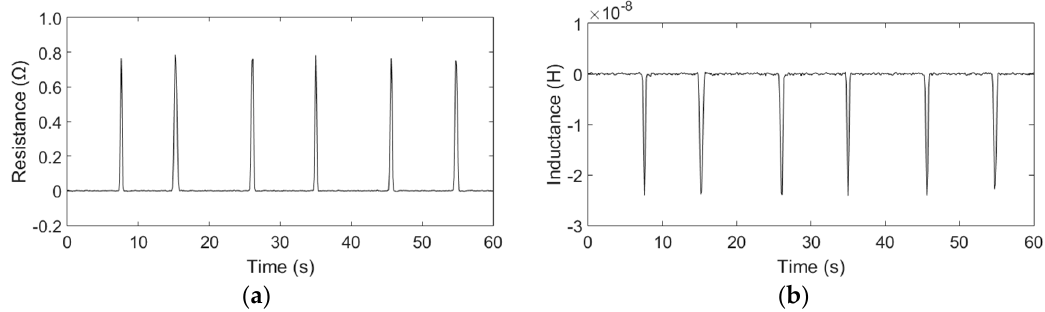
Figure 5. Detection results of the copper particles with sizes ranging from 150 μ m to 160 μ m: ( a ) Resistance detection results; ( b ) Inductance detection results.